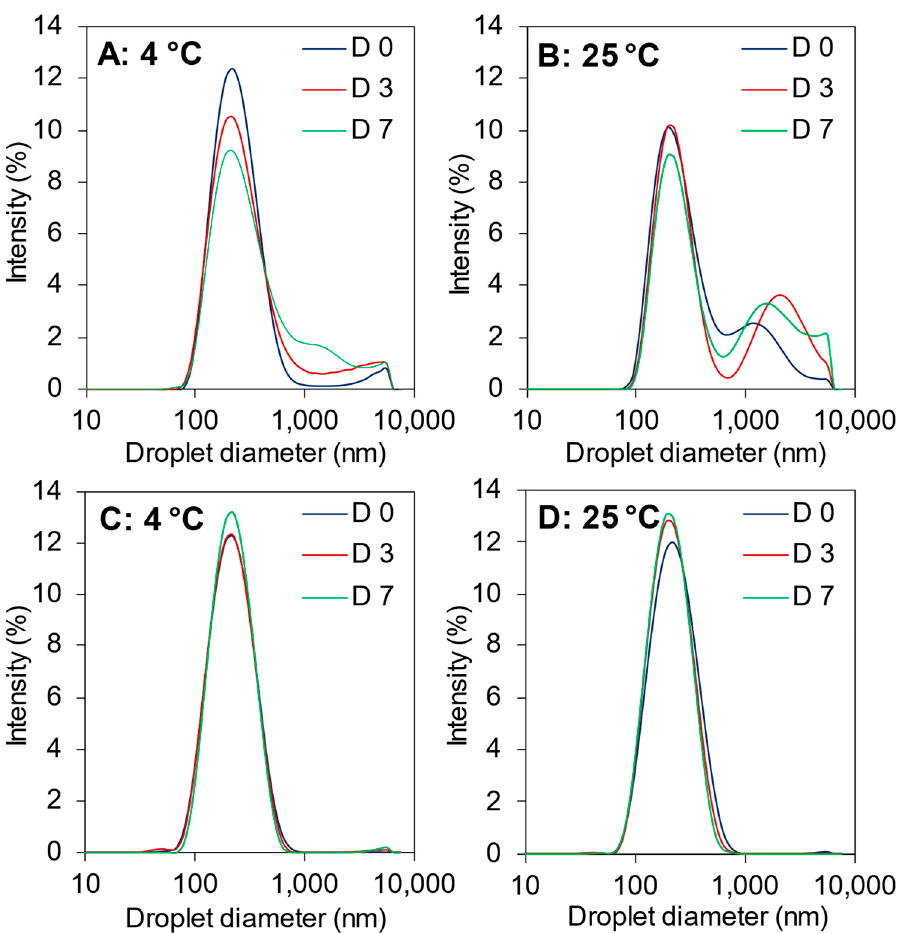
Figure 3. Droplet size distribution of UC–10F chymotrypsin ( A , B ) and UP–10F pepsin ( C , D ) WPI fraction nanoemulsions. Emulsifier concentration, 1%. Samples were stored at 4 and 25 °C for 7 d. D 0, D 3, and D 7 represent days 0, 3, and 7, respectively.